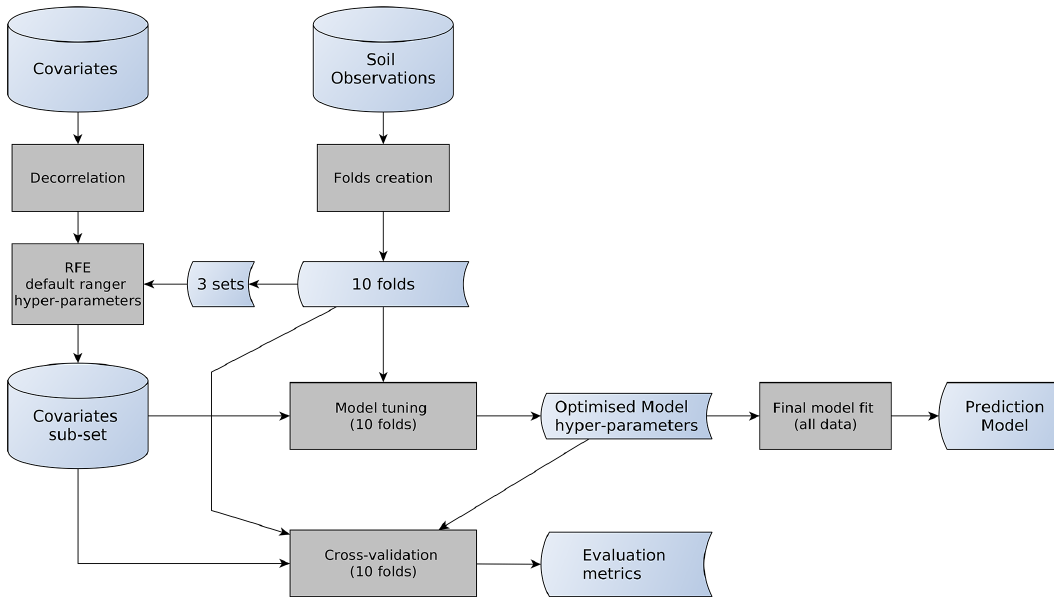
Figure 2. Detailed workflow for the Hyper-parameter selection and cross-validation.